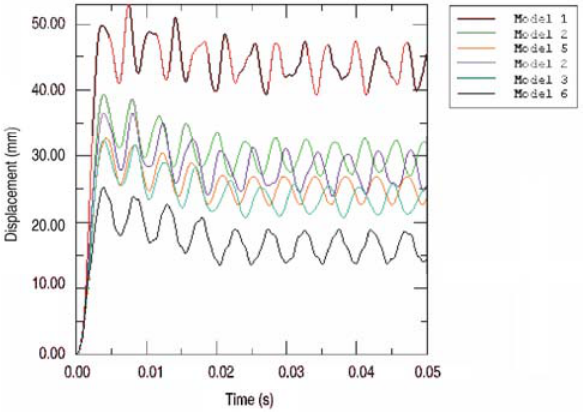
t = 20 ms Fig. 5. Influence of loading duration for model 1